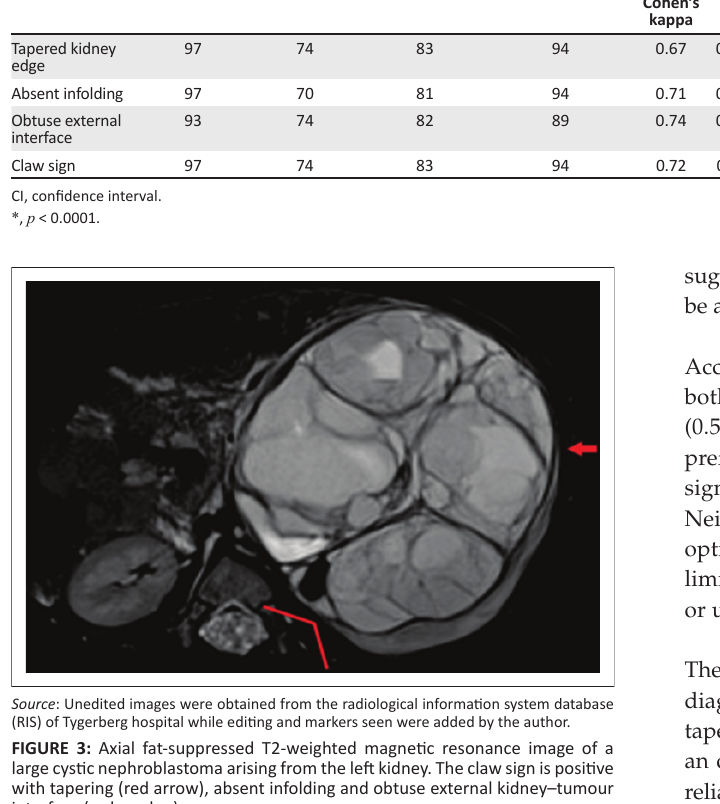
TABLE 1: Summary table of sensitivity ( % ), specificity ( % ), positive predictive value ( % ), negative predictive value ( % ), intra-rater and inter-rater reliability of the tumour– mass interface characteristics and the overall assessment of the claw sign. Tumour–mass interface characteristics